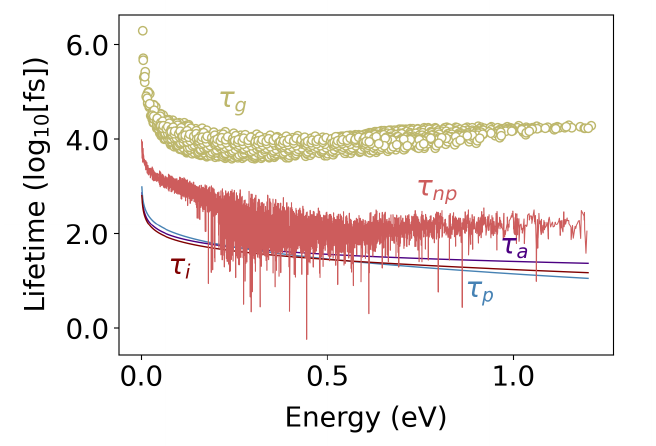
Figure 6. Electron lifetime for the different scattering mechanisms in Si 0.8 Ge 0.2 at 500 K with a carrier population of 10 20 1/cm 3 . In low energy states, electron impurity is the strongest scattering term. For higher energy levels, electron–phonon scattering is the main source of scattering. The electron–grain boundary ( l g = 50 nm) and electron–pore (pore–pore spacing of 20 nm) for 25% porosity are two additional scattering terms in polycrystalline porous Si 0.8 Ge 0.2 that are shown in green and light red,